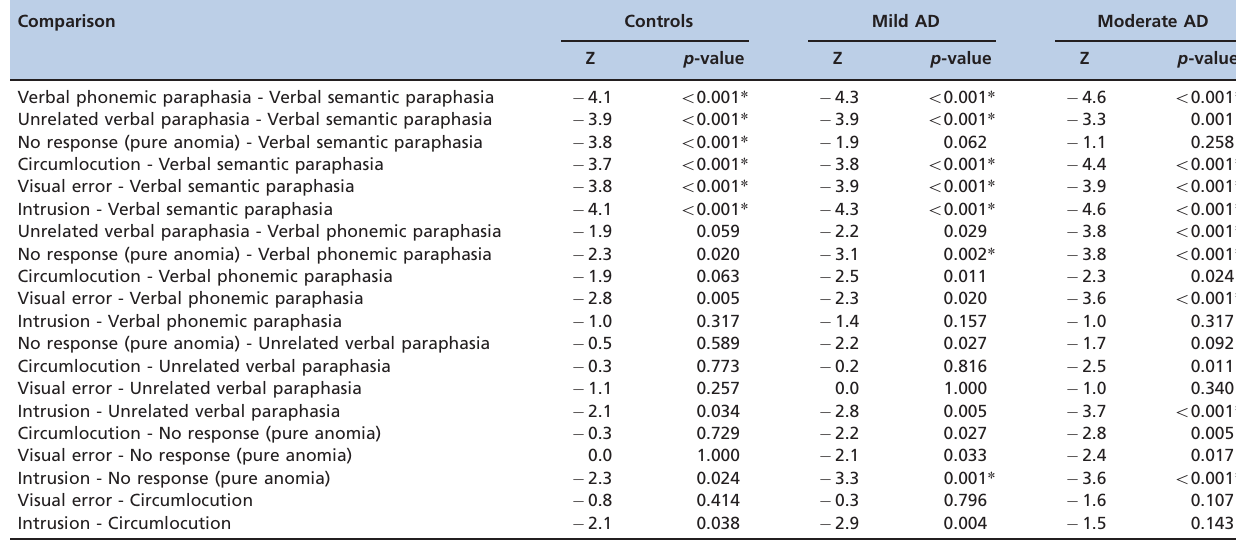
Table 3 – Comparisons between the types of errors according to the groups of subjects.